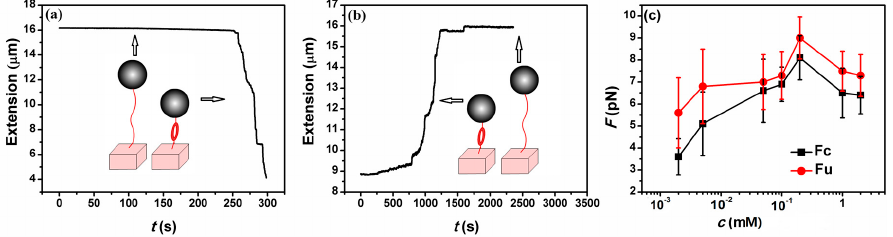
Figure 6. The curve of condensing and unraveling forces. ( a ) DNA extension-time curve measured by MT in DNA compaction process with K4. ( b ) DNA extension-time curve measured by MT in DNA pulling process with K4. ( c ) F C and F U of DNA in K4 solution.